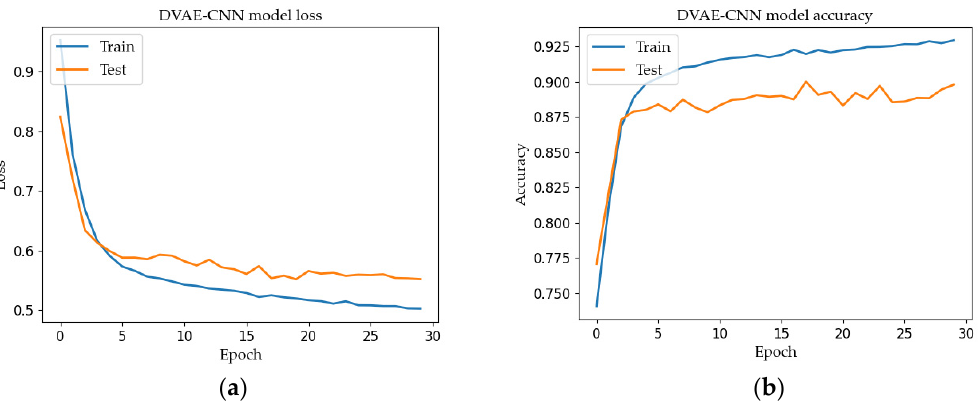
Figure 16. DVAE-CNN model: ( a ) loss curves; ( b ) accuracy curves.